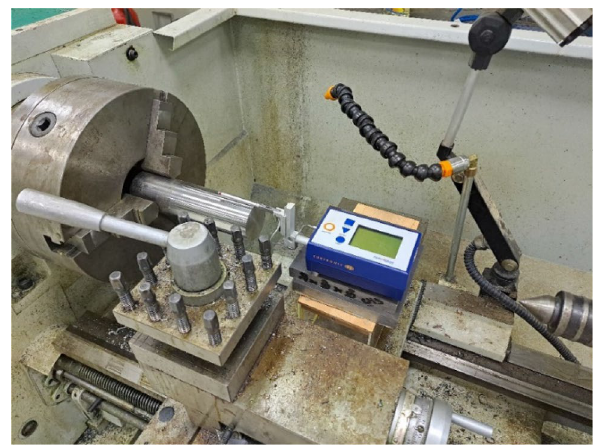
Fig. 4 Experimental setup center Lathe, Jesco Machinery, Taiwan Model